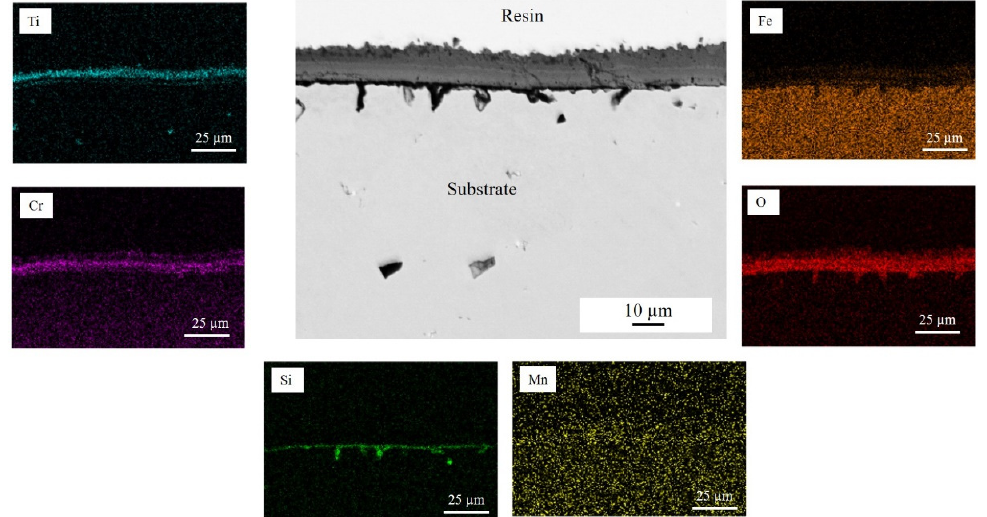
Figure 6. Backscattered electron image and EDX elementary maps of the cross section of the Ti-coated sample after 100 h aging at 800 °C under ambient air.